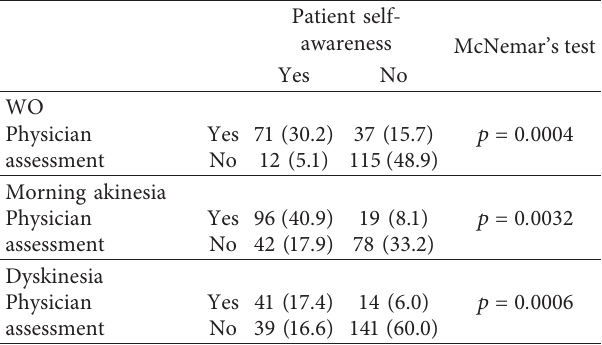
Table 4: Differences in the perception of WO, morning akinesia, and dyskinesia between patient self-awareness and physician assessment.